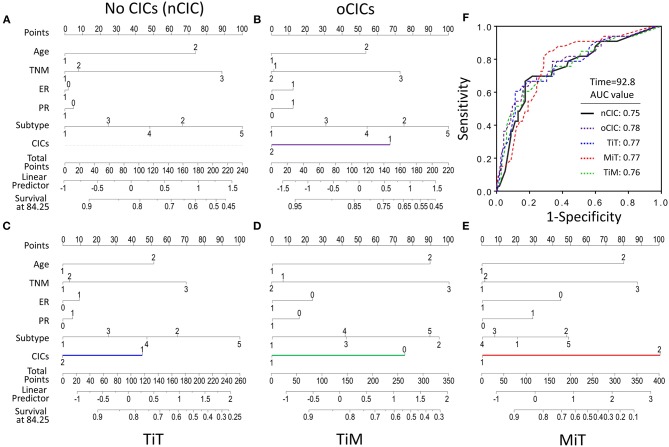
Contribution of subtyped cell-in-cell structures to survival prediction by nomogram analysis. (A) Prognostic nomogram in the absence of CICs as a viable. (B–E) Prognostic nomogram with oCICs (B), or TiT (C), or TiM (D), or MiT (E) as a variable, respectively. For the probability of patient survival for 84.25 months, summing up the points from individual variable, locating its position on the axis of total points to determine the corresponding survival probability based on the bottom line (survival at 84.25) of the nomogram. In addition to CICs, age, TNM stage, ER and PR statuses, and cancer subtypes were included in the nomogram analysis. (F) The AUC of different nomogram models from observed data.